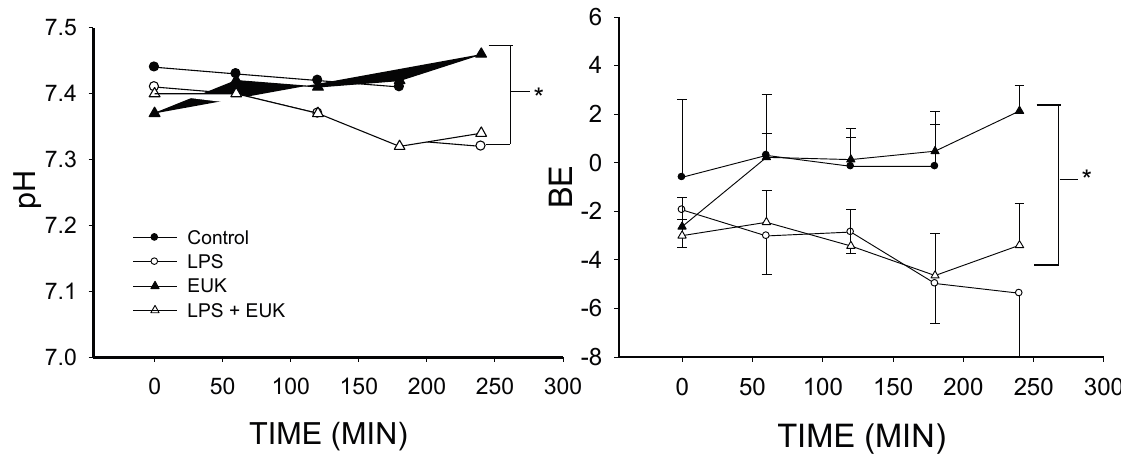
Figure 1. Mean arterial blood gases over time for the four conditions (mean ± SEM). Upper left , PO 2 fell in the LPS and LPS plus EUK-134 (LPS + EUK) groups and did not change in the control or EUK-134 alone (EUK) groups; Lower left , pH fell in the LPS and LPS + EUK groups but did not change in the control or EUK groups; Upper right , PCO 2 was comparable across all the groups (by design it was controlled by adjusting the ventilator); and Lower right , base excess (BE) fell in both the LPS and LPS + EUK groups, but not in control or EUK groups. * p <